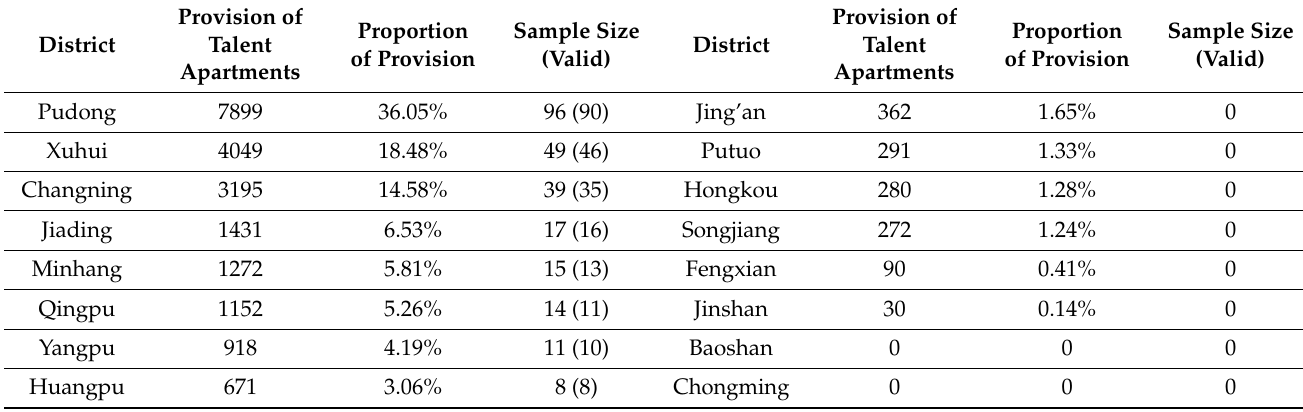
Table 1. Sample distribution in Shanghai.